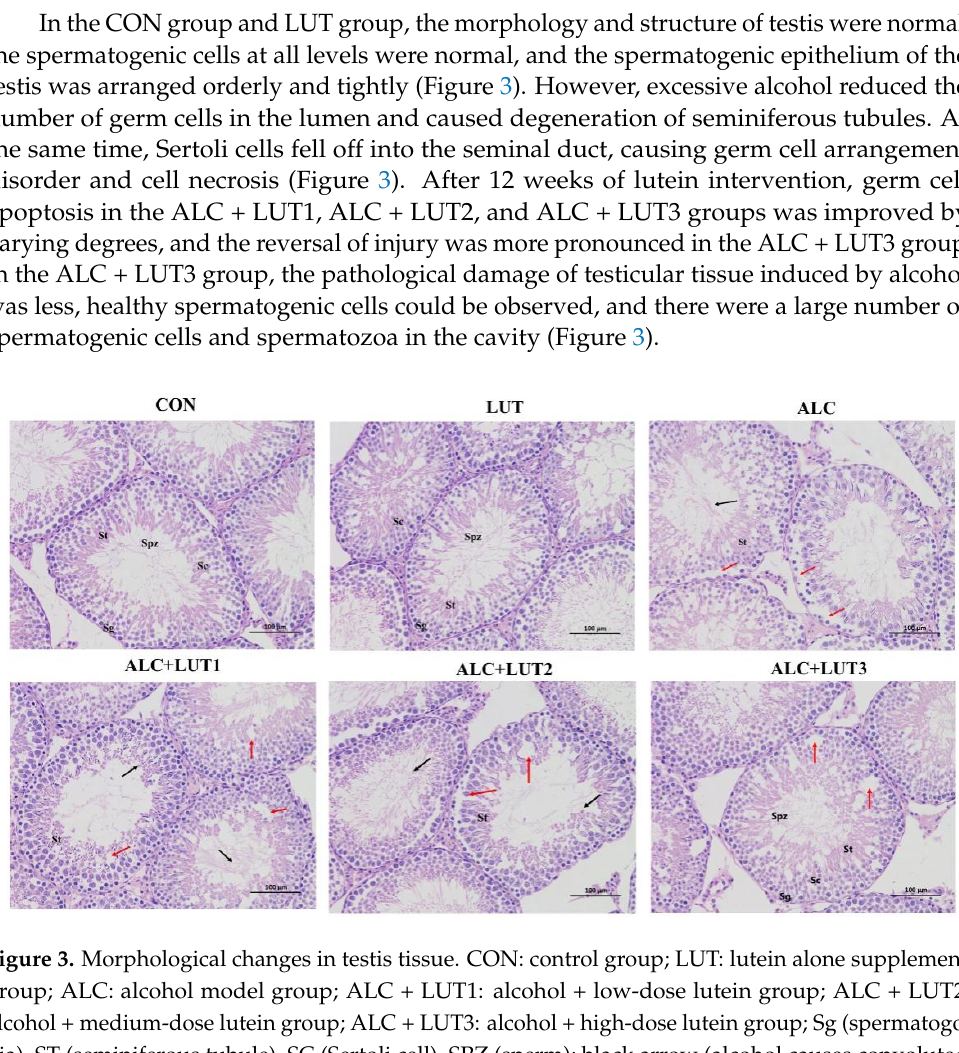
Figure 2. Effect of lutein on sperm quality in alcohol-treated rats. ( A ) Sperm morphology; ( B ) sperm count; ( C ) sperm motility; ( D ) sperm abnormality; CON: control group; LUT: Lutein alone supplement group; ALC: alcohol model group; ALC + LUT1: alcohol + low-dose lutein group; ALC + LUT2: alcohol + medium-dose lutein group; ALC + LUT3: alcohol + high-dose lutein group; The red arrow is the malformed sperm; a, vs. the control group, p < 0.05 (CON); b, vs. the alcohol group, p < 0.05 (ALC); c, vs. the ALC + LUT2 group, p < 0.05, d, vs. the ALC + LUT3 group, p < 0.05 (n = 10, mean ± SD).